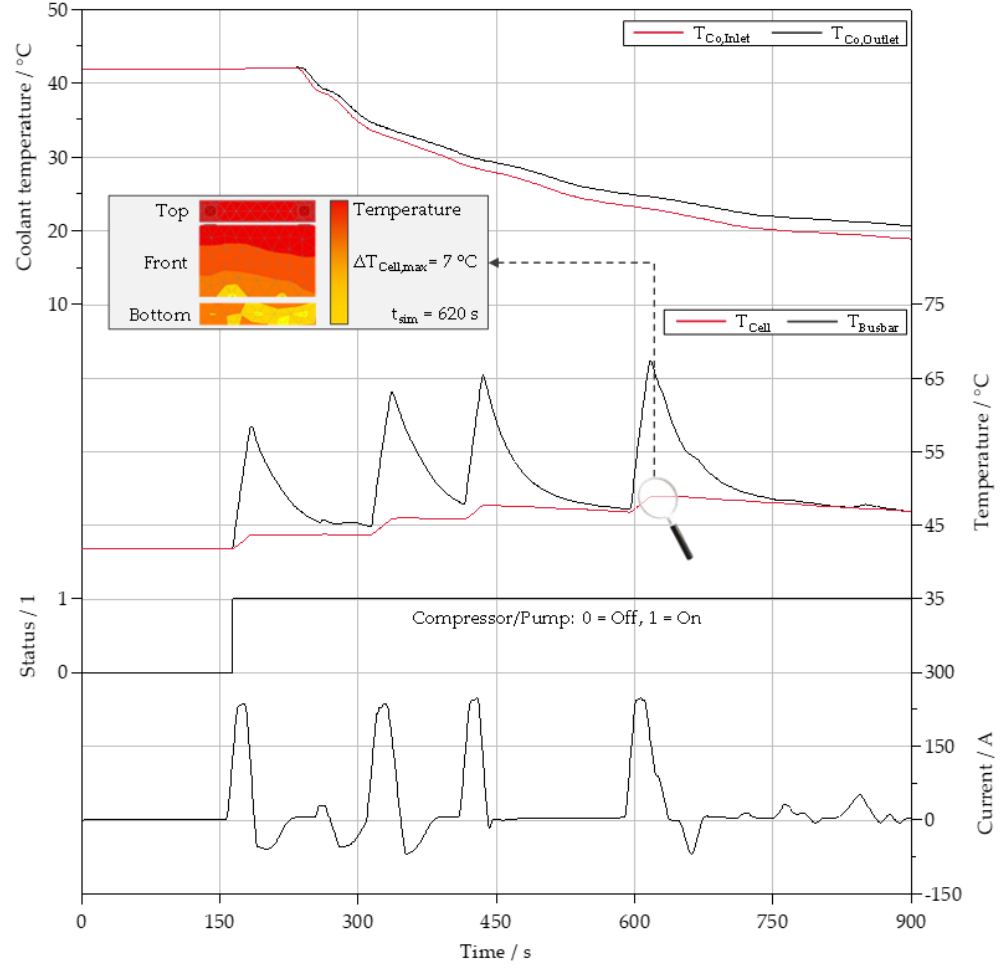
Figure 17. Simulation results of thermal battery performance and the corresponding cooling system during kickdown events at 40 ◦ C ambient